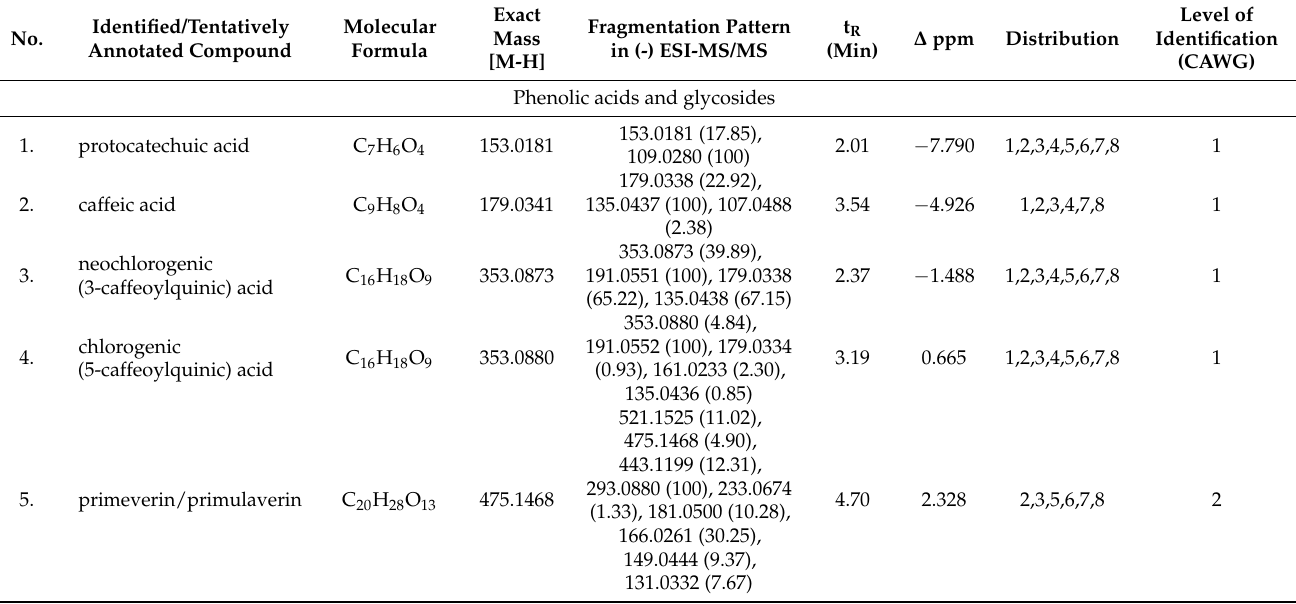
Table 2. Specialized metabolites in Primula auriculata